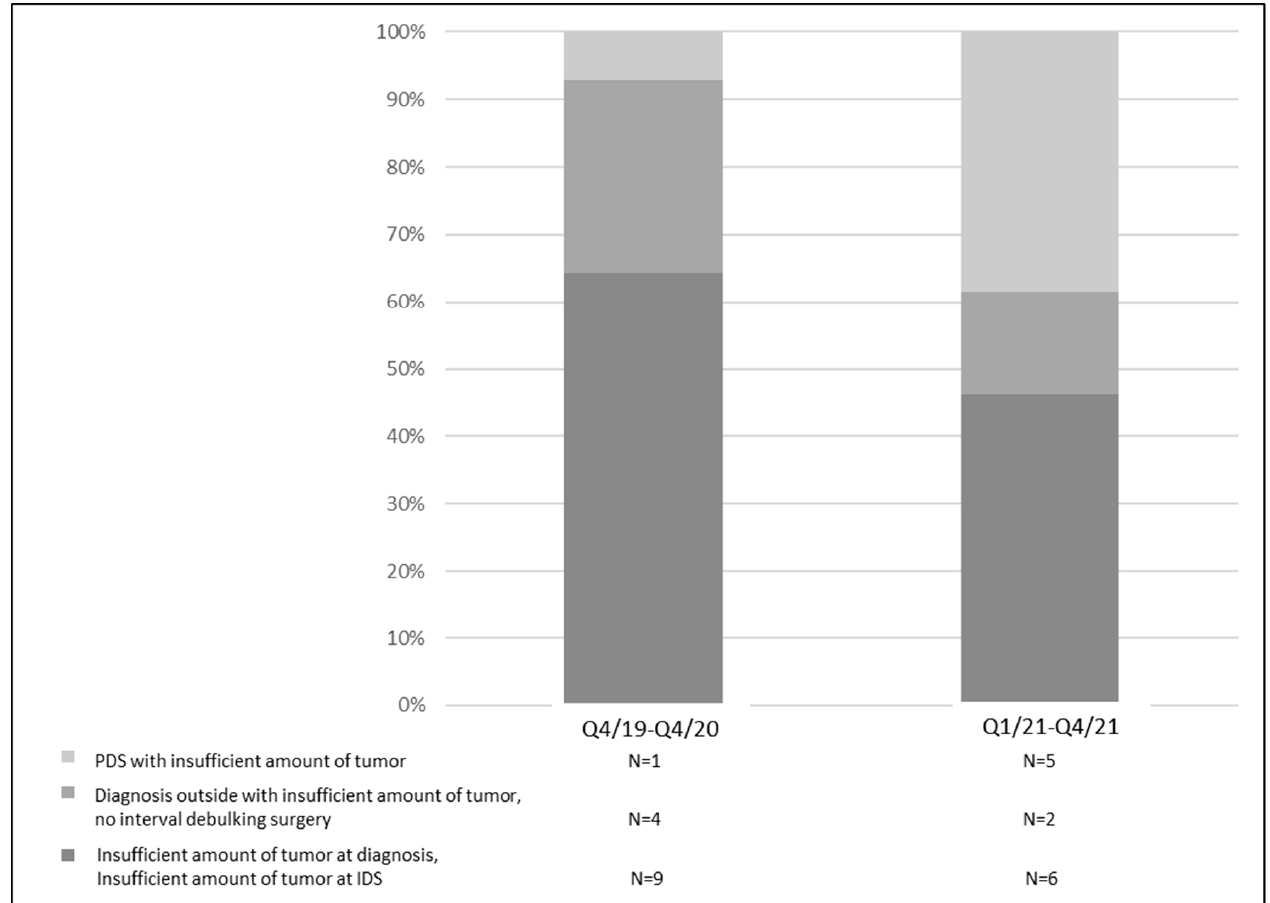
Figure 3. Reasons for insufficient amount of tumor tissue, leading to insufficient HRD testing during the implementation phase; Q4/19–Q4/20 N = 56, and Q1/21–Q4/21 N = 113. Of the 163 patients with an available GI-score, an HRD (cutoff ≥ 42) was detected in 70 patients (42.9% of the patients with an HRD test result). In an additional 3 patients (1.8% of the patients with an HRD test result), an HRD was defined due to a somatic BRCA1 mutation with GI-scores of 40, 28, and 26, leading to a positive HRD score in 44.7% of the